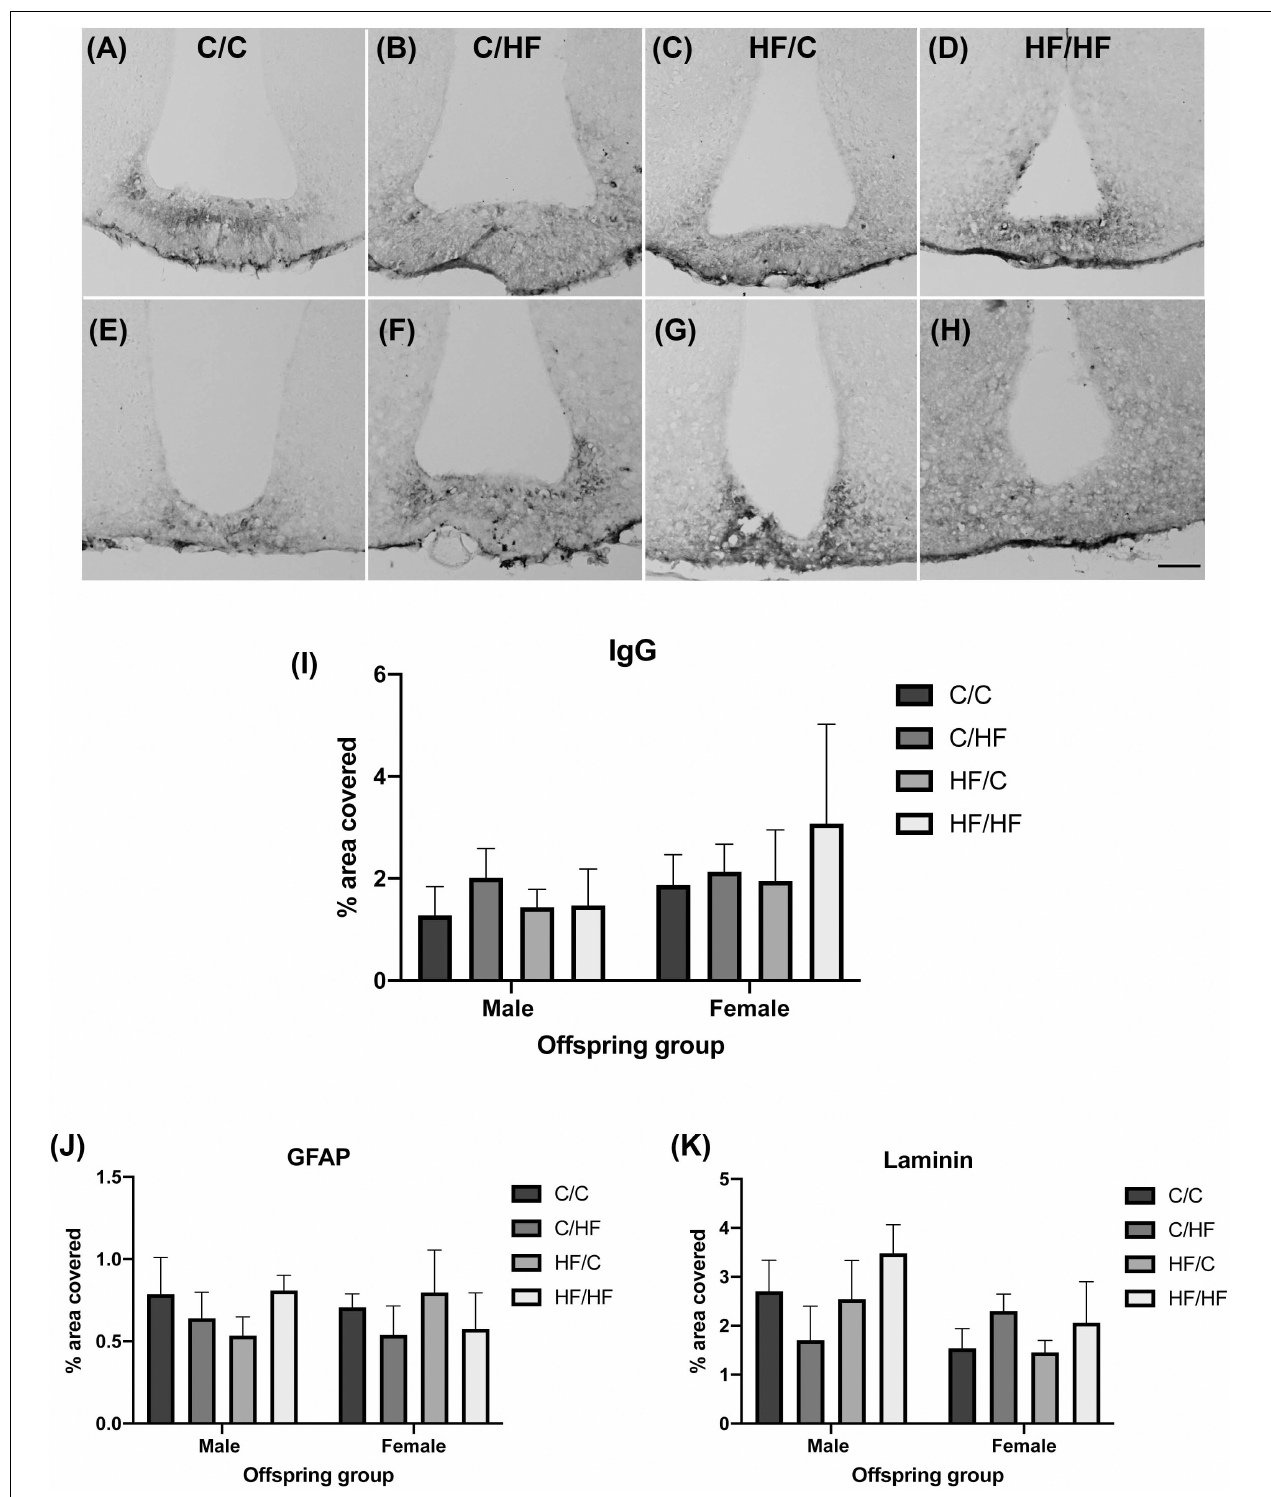
FIGURE 6 | Effect of pre- and post-natal high fat diet on hypothalamic blood–brain barrier integrity in male and female offspring. (A–H) Photomicrographs of the median eminence stained for IgG in 16-month old male (A–D) and female (E–H) C/C (A,E) , C/HF (B,F) , HF/C (C,G) and HF/HF (D,H) mice. (I) Quantification of IgG extravasation in the median eminence. (J,K) Quantification of median eminence area positive for GFAP (J) and laminin (K) . Data represent mean ± SEM. Scale bar = 200 µ m.